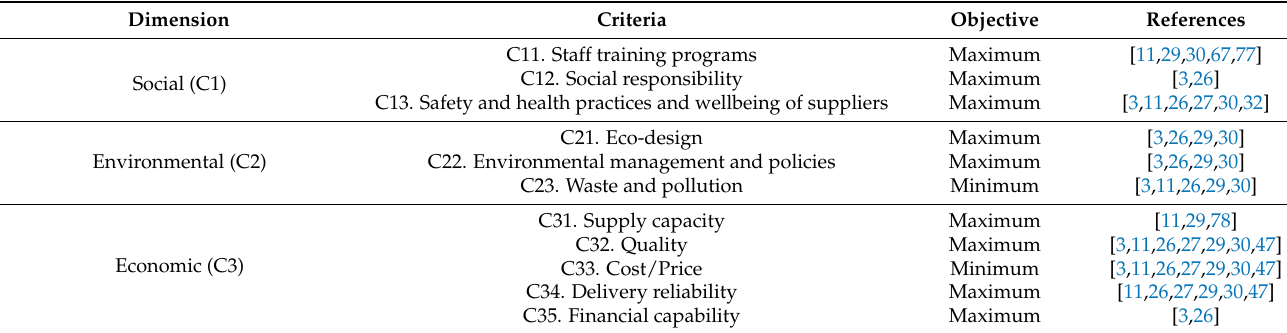
Table 5. The list of criteria and their